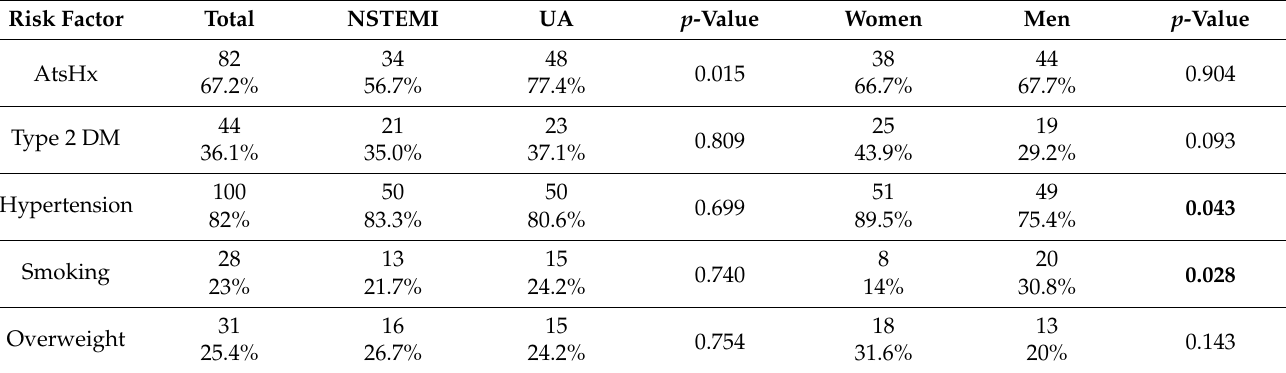
Table 1. Risk factor distribution and Chi-square test